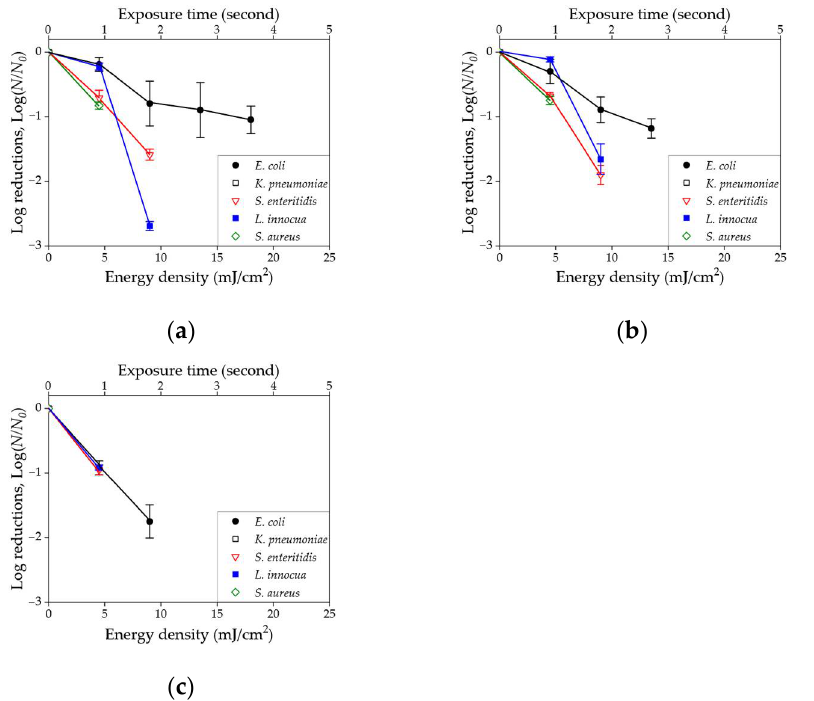
Figure 7. Series of survival plots for five different microorganisms ( a ) in liquid sample, ( b ) on nu- trient-rich agar, and ( c ) on solid tile surface. nutrient-rich agar, and ( c ) on solid tile